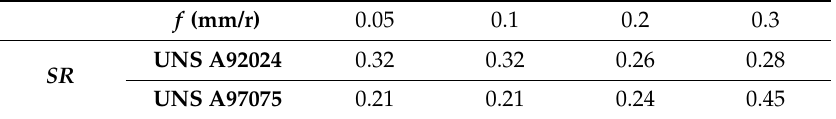
Table 4. Segmentation Ratio.